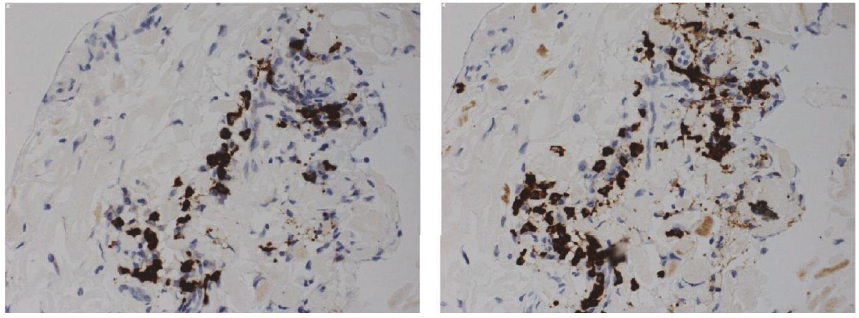
Figure 3: In situ hybridization of immunoglobulin light chains of the specimens. Both 𝜆 and 𝜅 chains subunits were strongly detected in the infiltrated inflammatory